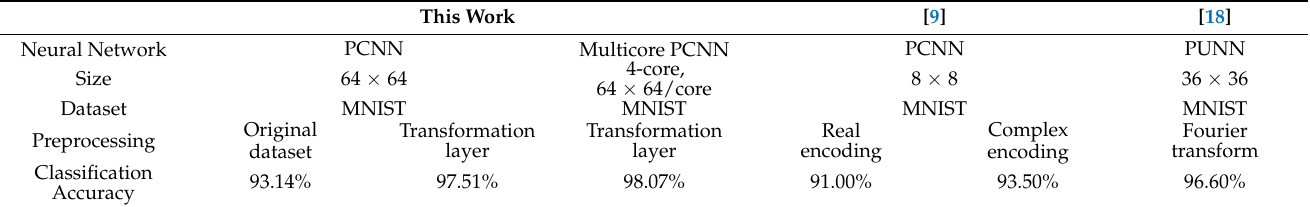
Table 4. Comparison of the multicore PCNN with photonic neural networks in the literature. PUNN: photonic unitary neural